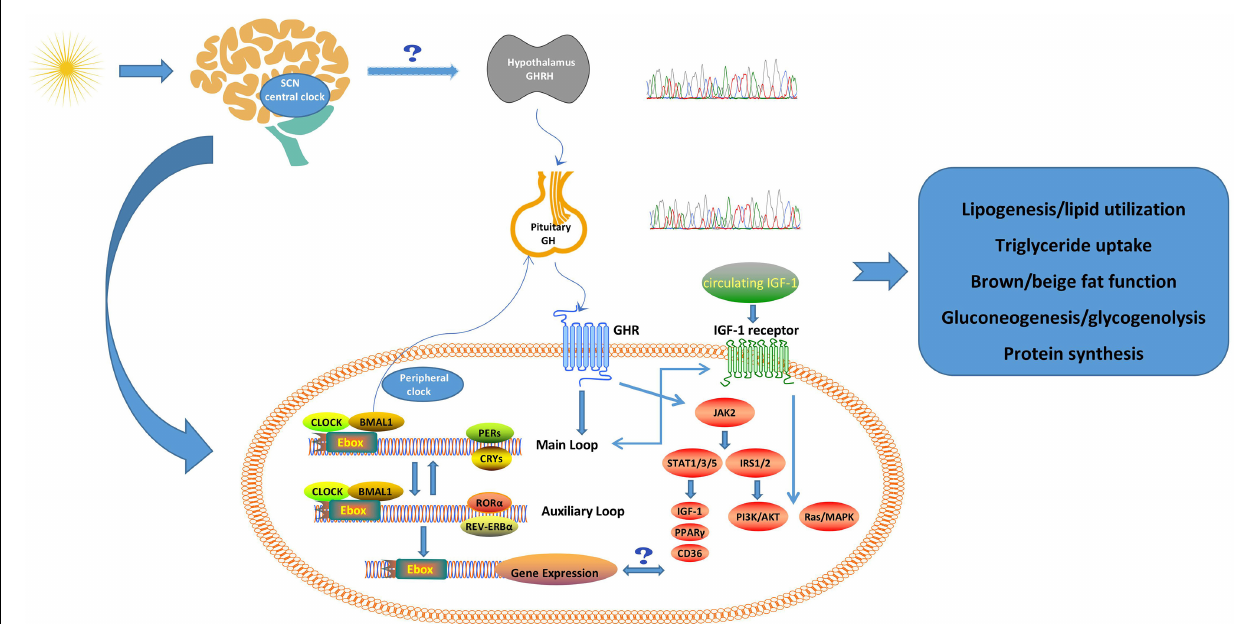
FIGURE 1 | Possible crosstalk between clock system and GH/IGF-1 axis. The CLOCK system forms an internal circadian rhythm in the SCN during light/dark cycles. The SCN may synchronize the GH secretion rhythm with the dimming cycle through somatostatin neurons, and the change of the clock system may be related to the pulsatile release of GH. The GH/IGF-1 axis and clock system may interact further on the metabolism through several pathways in peripheral tissues (e.g., liver, fat). The physiological roles of GH and IGF-1 are also summarized in this figure (Huang et al., 2020b). SCN, suprachiasmatic nucleus; GHRH, Growth hormone-releasing hormone; GH, growth hormone; GHR, growth hormone receptor; IGF-1, insulin-like growth factor 1; BMAL1, brain-muscle-arnt-like protein 1; PERs, periods; CRYS, Cryptochromes; ROR α , retinoic acid-related orphan receptor α ; Ebox, enhancer motif; JAK2, Janus kinase 2; STAT, signal transducer and activator of transcription; IRS, insulin receptor substrate; PPAR γ , peroxisome proliferator-activated receptor γ ; PI3K/Akt, phosphatidylinositol 3-kinase/protein kinase